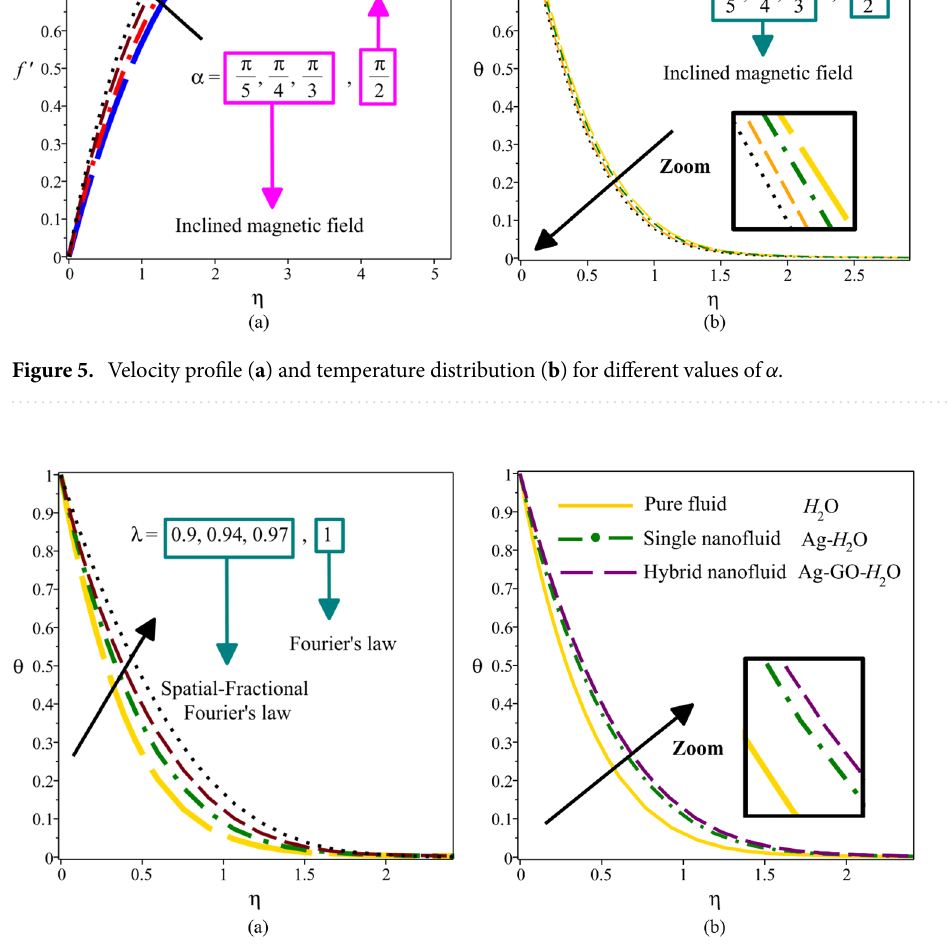
Figure 6. Temperature distribution for different values (cid:31) ( a ) and for different working fluids ( b